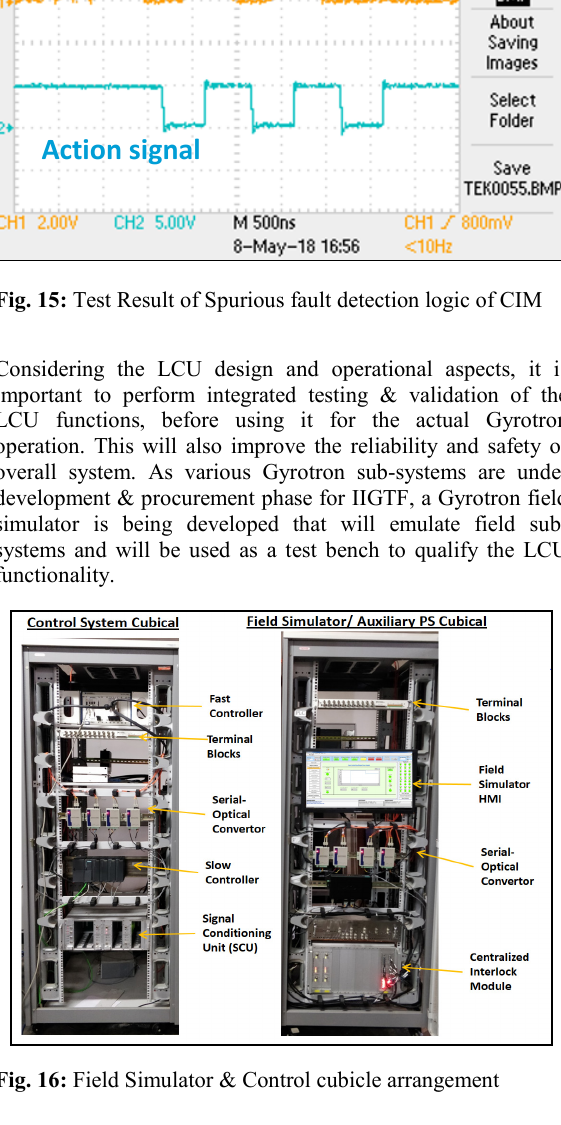
Fig. 13: Summary of EMC Test performance of CIM